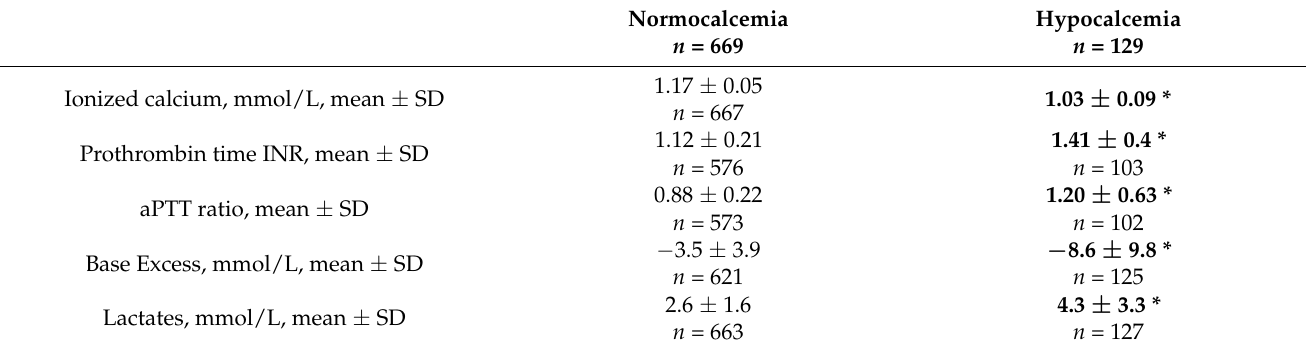
Table 2. Biological characteristics of the 798 patients ( n number of patients, * p < 0.01, bold: significant).